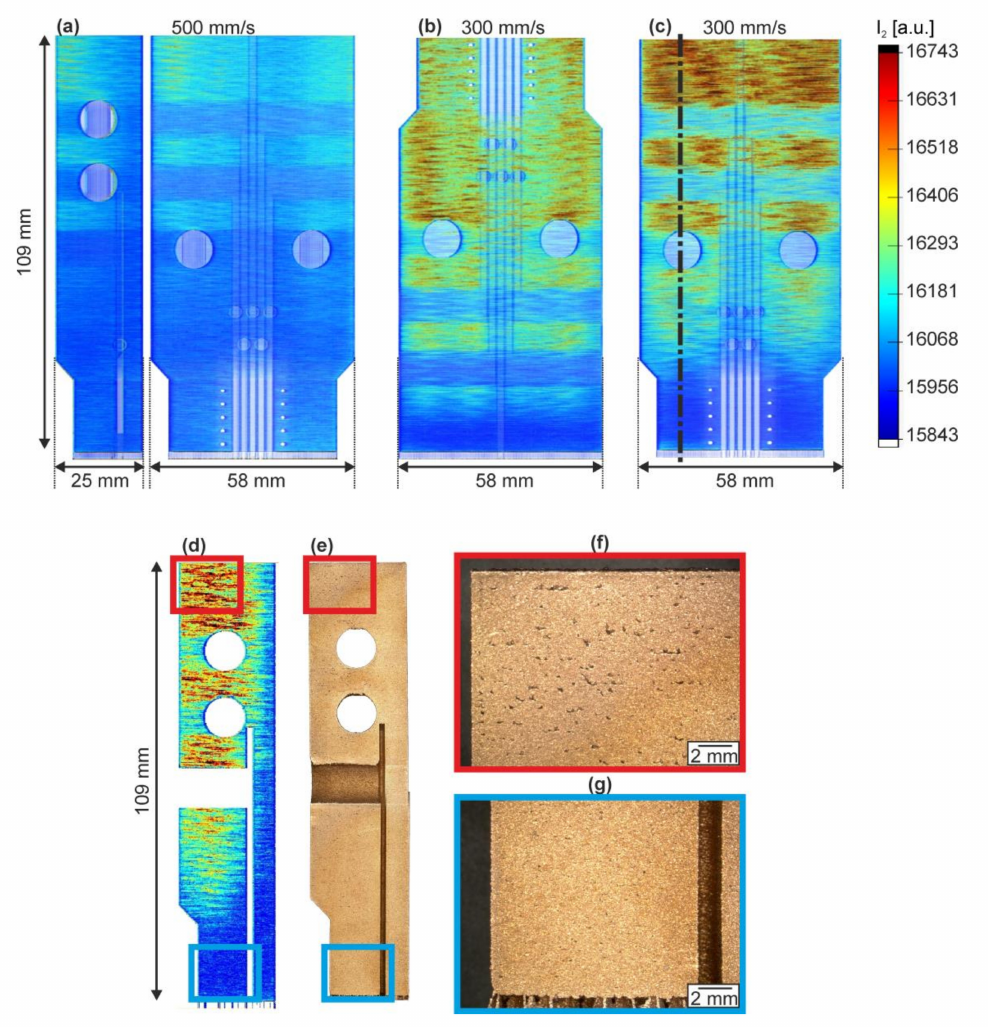
Figure 11. 3D visualization of the MPM response I 2 for 3 di ff erent TMF-panel segments (all: P = 400 W, t = 50 µ m, h = 120 µ m; visualization voxel size 0.15 × 0.15 × 0.15 mm 3 ). ( a ) top end manufactured with v = 500 mm / sandsupportsinchannelopenings; ( b )bottomend, v = 300mm / s; ( c )topend, v = 300 mm / s. The dimensions of the segments are 25 × 58 × 109 mm 3 . Corresponding cross-sections of I 2 ( d ) and the manufactured segment ( e ) with markings corresponding to the LOM images show di ff erent material densities in the upper ( f ) and the bottom part ( g